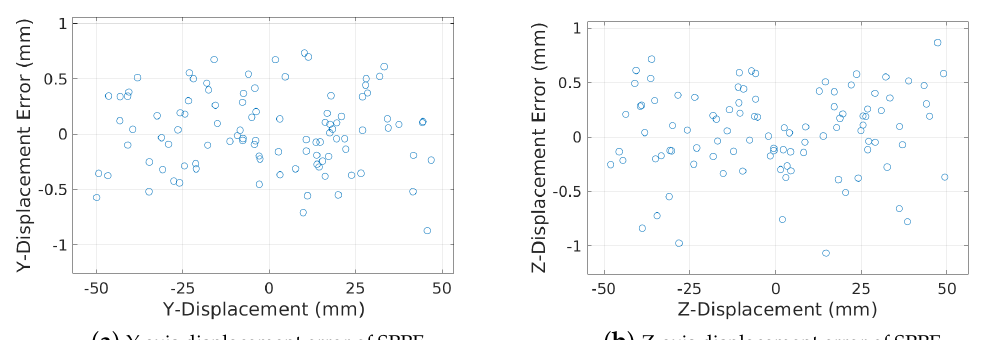
Figure 14. 2-D deviation errors of